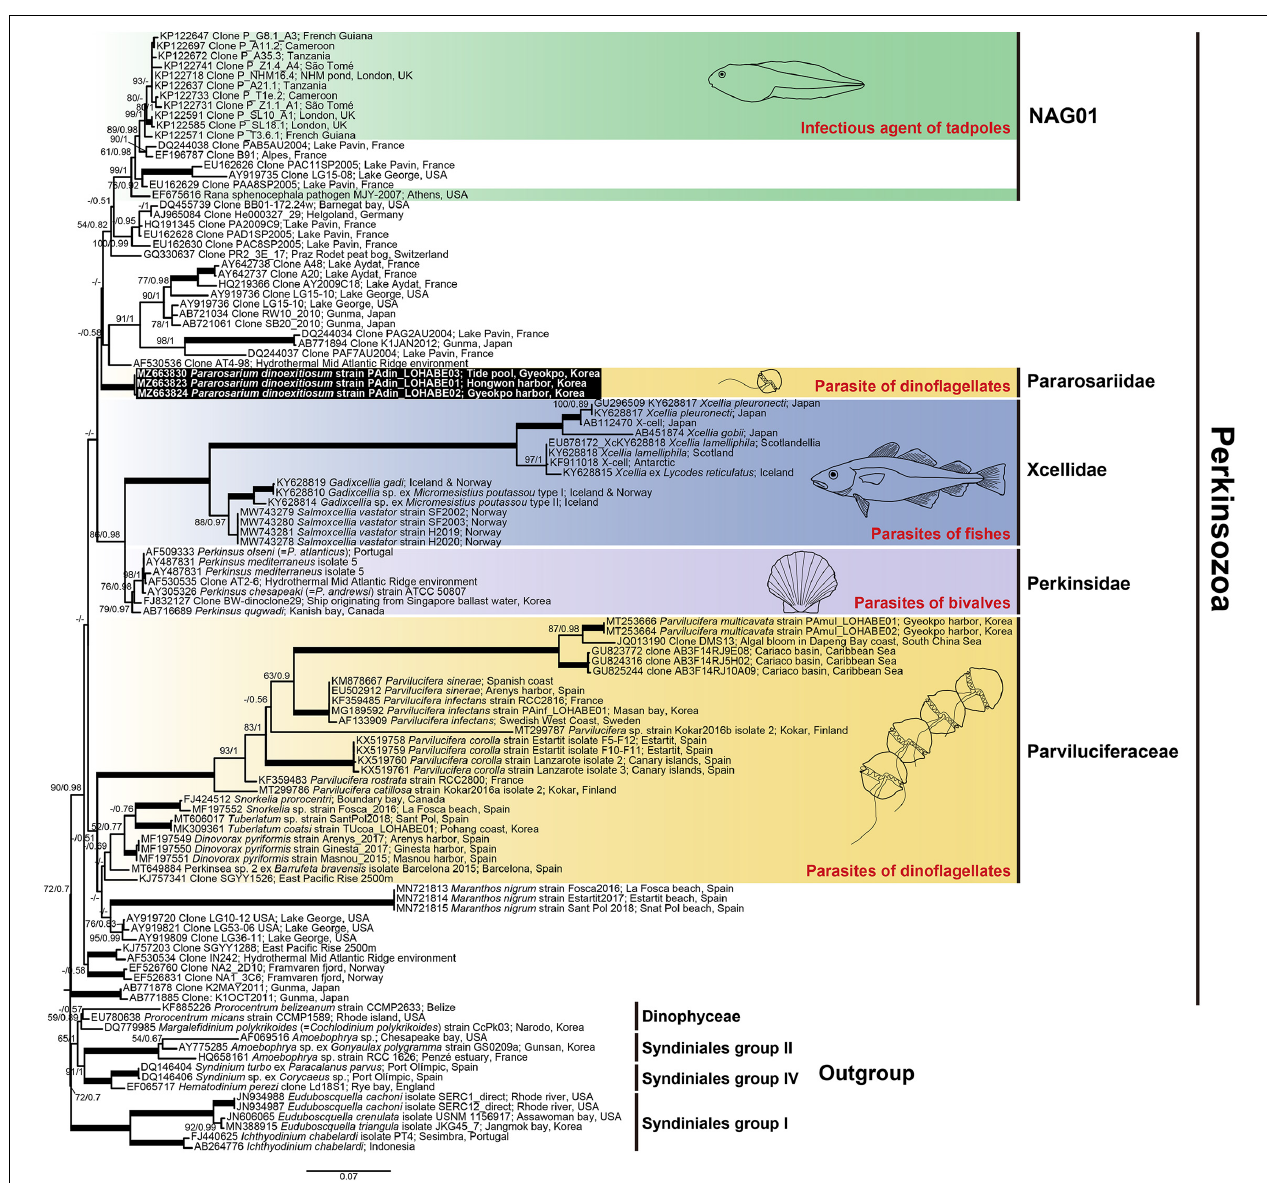
FIGURE 10 | Maximum likelihood phylogenetic tree of the phylum Perkinsozoa inferred from small subunit rRNA gene sequences (1,524 bp). Sequences of the three dinoflagellates, six Syndiniales group I, three Syndiniales group II, and three Syndiniales IV were used as outgroups. The sequences of Pararosarium dinoexitiosum obtained in this study are indicated by the black box. The colored areas with drawings indicate the families of Perkinsozoa and their hosts. The values of bootstrap percentages (left) and Bayesian posterior probabilities (pp) (right) are shown when higher than 50% and 0.5 pp, respectively. Thick lines indicate support values of 100% and 1